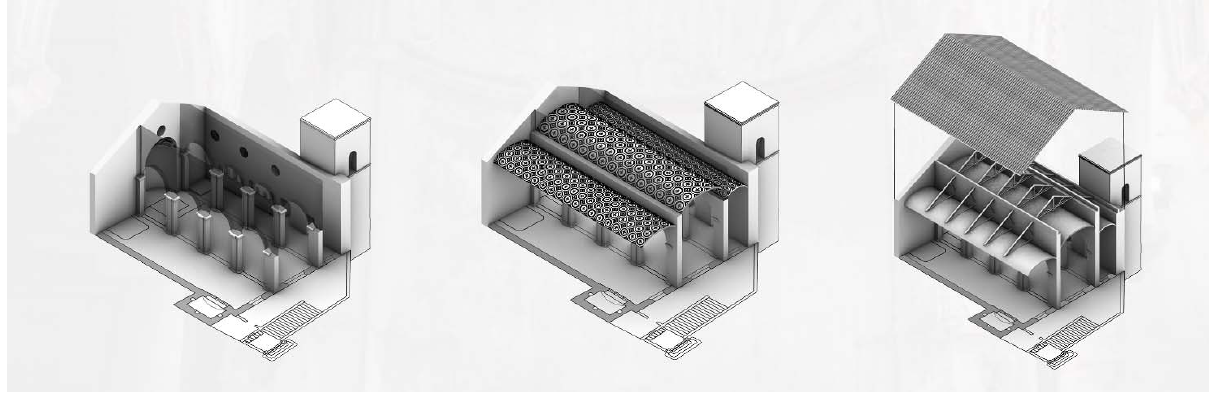
Figure 15. Model of the church pre-earthquake. Graphic elaboration by Mariarosa Sarracco.